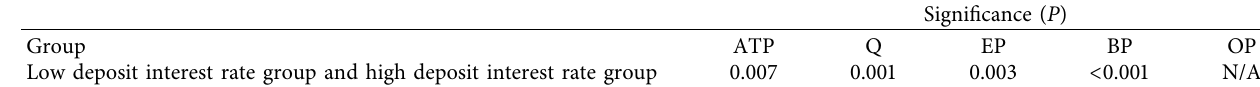
Table 6: Nonparametric test of intergroup indicators of deposit interest rate.